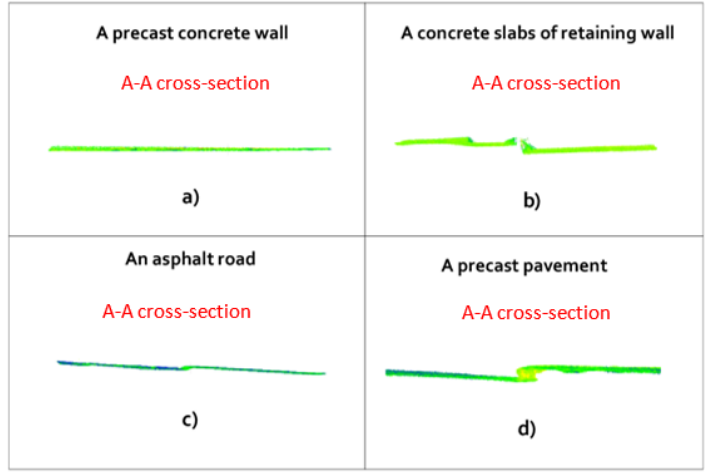
Figure 6. Cross-section view of the point clouds shown in Figure 3, respectively.